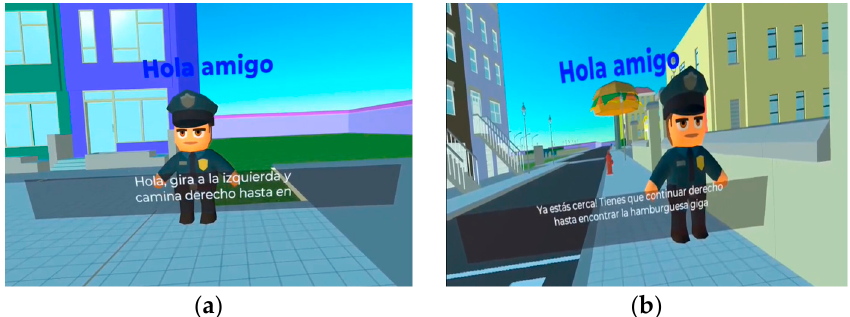
Figure 9. ( a ) Avatar within the virtual environment providing an instruction. ( b ) Avatar within the environment indicating that it is close to its destination.